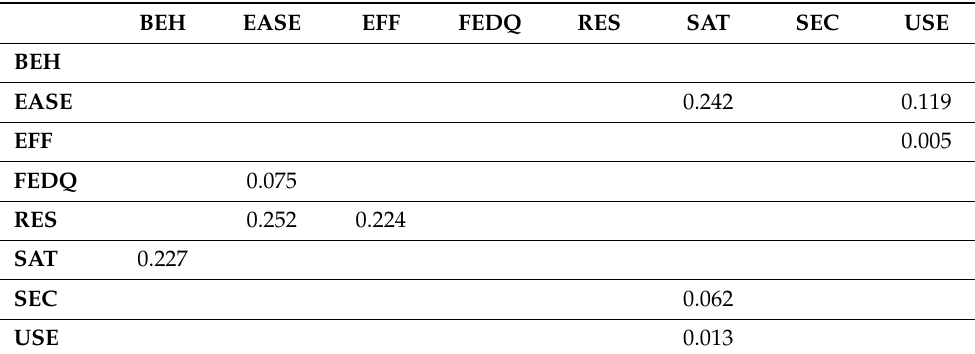
Table 10. Results of testing the predictive relevance of exogenous